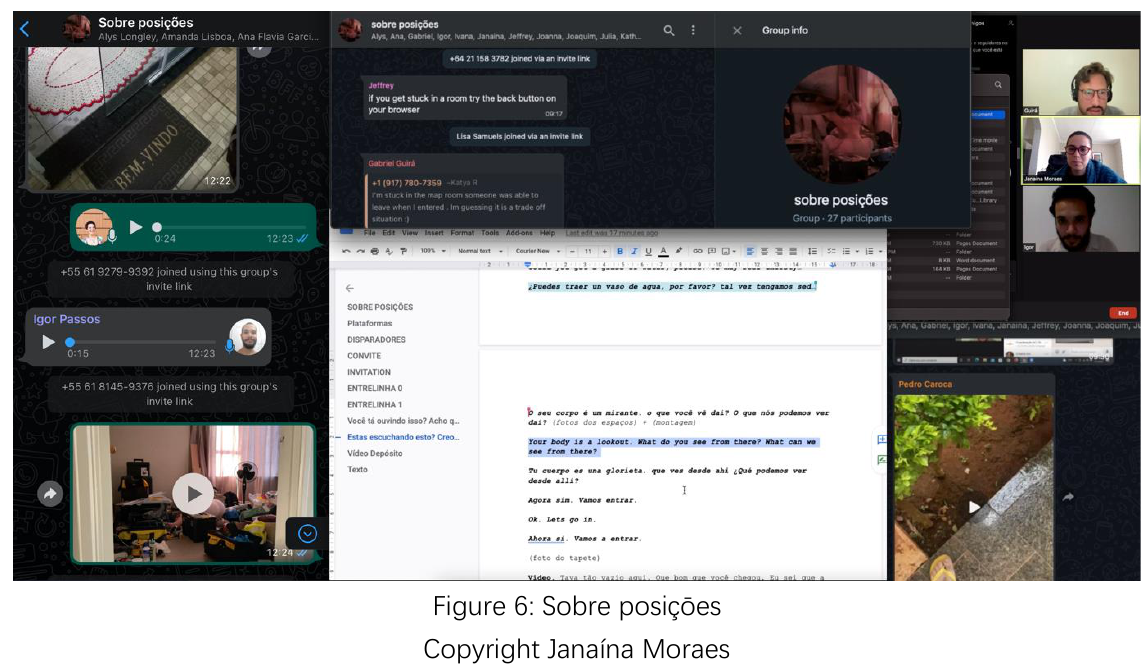
Figure 6: Sobre posiçōes Copyright Janaína